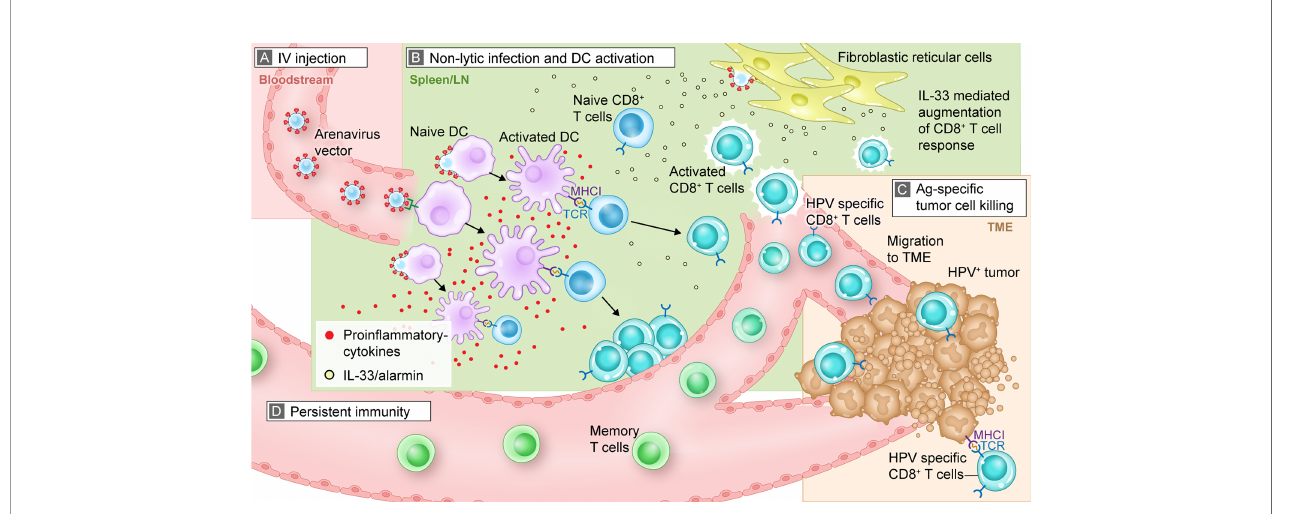
FIGURE 1 | Mechanistic summary of how arenavirus vectors are hypothesized to exert their effects in vivo to trigger an antitumor, antigen-speci fi c immune response. This graphic representation uses HB-201 and an HPV+ tumor as an example for illustrative purposes. (A) After IV injection, HB-201 rapidly enters the bloodstream, where viral vectors travel to lymphoid tissue; (B) once in the lymphoid organs, HB-201 vectors infect and activate APCs such as DCs. Antigen-speci fi c CD8 + T cells are then activated and proliferate in the presence of key in fl ammatory cytokines and the alarmin cytokine, IL-33, which is secreted by infected fi broblastic reticular cells; (C) polyfunctional T cells migrate to the TME, where they interact with and kill cancer cells expressing HPV E7 and E6 antigen epitopes via MHCI; (D) development of memory T cells provides persistent immunity that can protect from tumor recurrence. Ag, antigen; APC, antigen presenting cell; DC, dendritic cell; HPV, human papilloma virus; IL, interleukin; IV, intravenous; MHCI, major histocompatibility complex class I; TCR, T cell receptor; TME, tumor